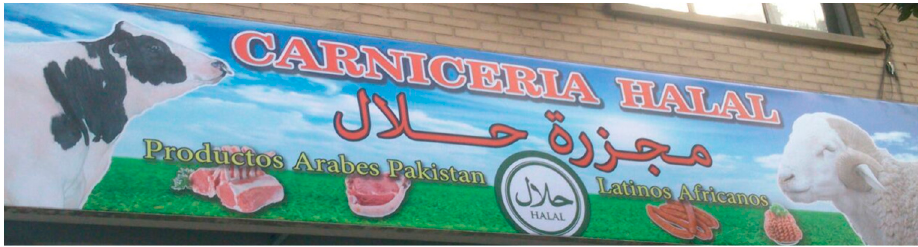
Figure 39. Valencia: Arabic-Spanish sign on a butchery.